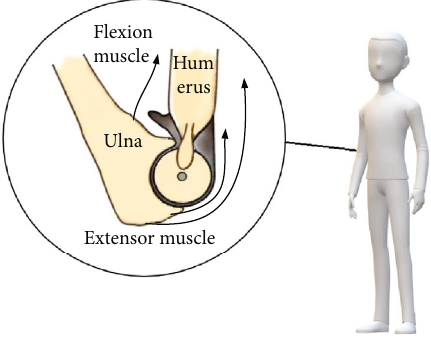
Figure 4: Sagittal view of the humeral ulnar joint during fl